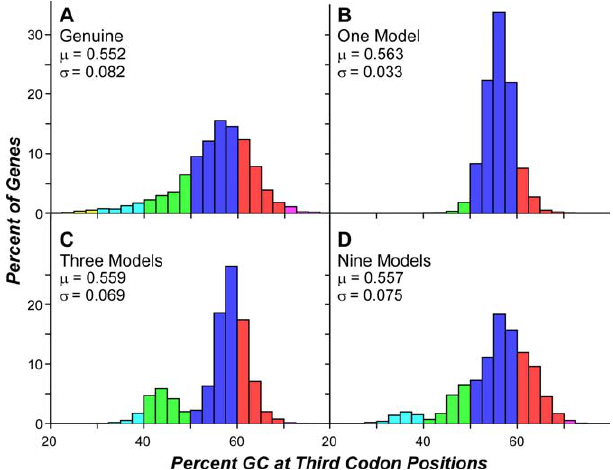
Figure 1. Variability within Genuine and Artificial E. coli Genomes Created with Variable Numbers of Gene Models The variability of percent GC at third-codon positions of genes is shown within the genuine E. coli genome (A), as well as artificial genomes created using one (B), three (C), and nine (D) gene models. Genes were clustered according to frame-specific DNC; l and r represent the mean and standard deviation of the distribution. For comparison between graphs, colors demarcate corresponding ranges of GC content. DOI: